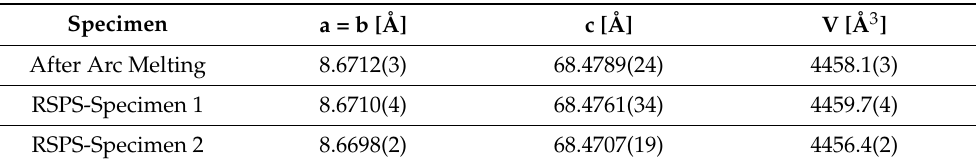
Figure 3. SEM image (backscattered electron detector) of specimen 1 sintered at 900 ◦ C under 100 MPa for 5 min. Few black and white spots as well as dark gray areas correspond to signals from voids, tungsten carbide, and regions with higher Si content, respectively. Table 1. Lattice parameters of Ca 14 Si 19 specimens determined from Rietveld fitting analysis of the X-ray diffraction data after the arc melting and the RSPS